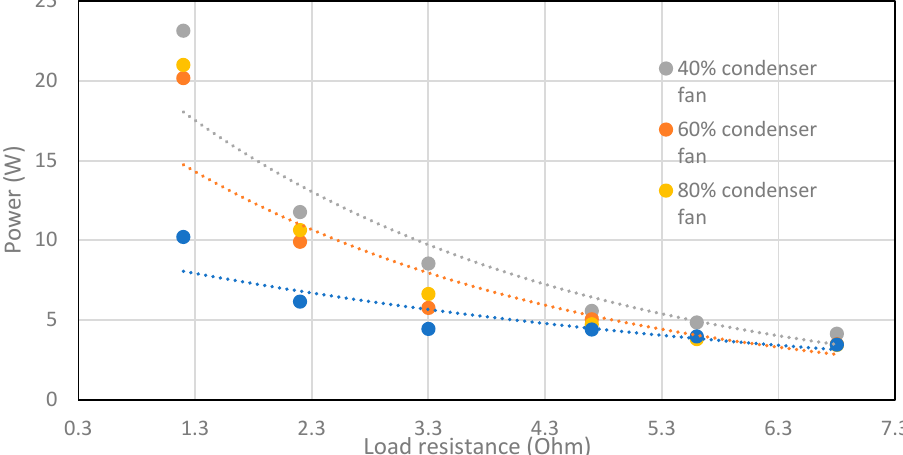
Figure 13. Variation of TEGs power with load resistance at different values of condenser load.